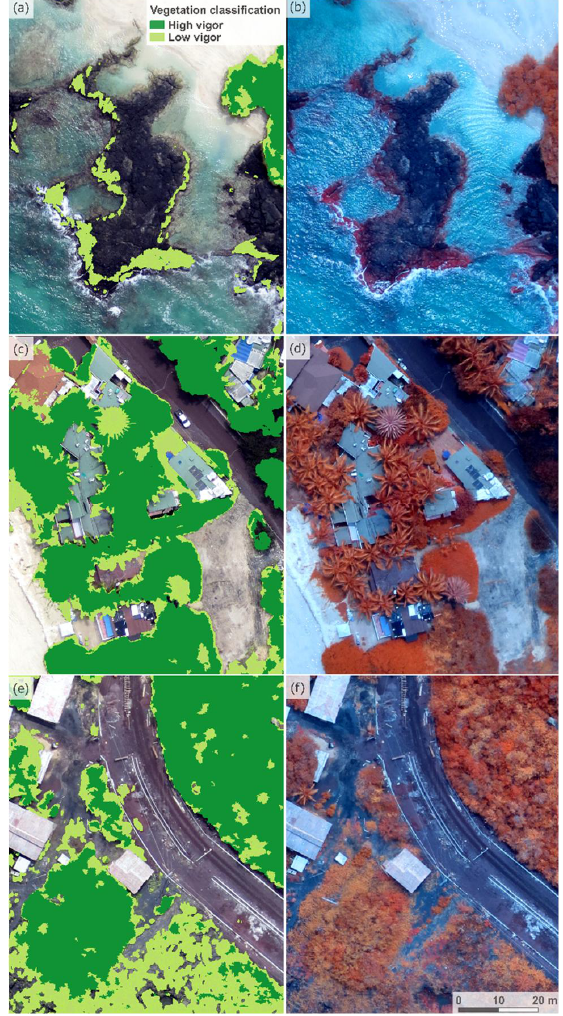
Figure 10. Classification detailed areas. (a - b) Algae in intertidal zone; (c - d) Palm urban vegetation; (e - f) Mangrove vegetation